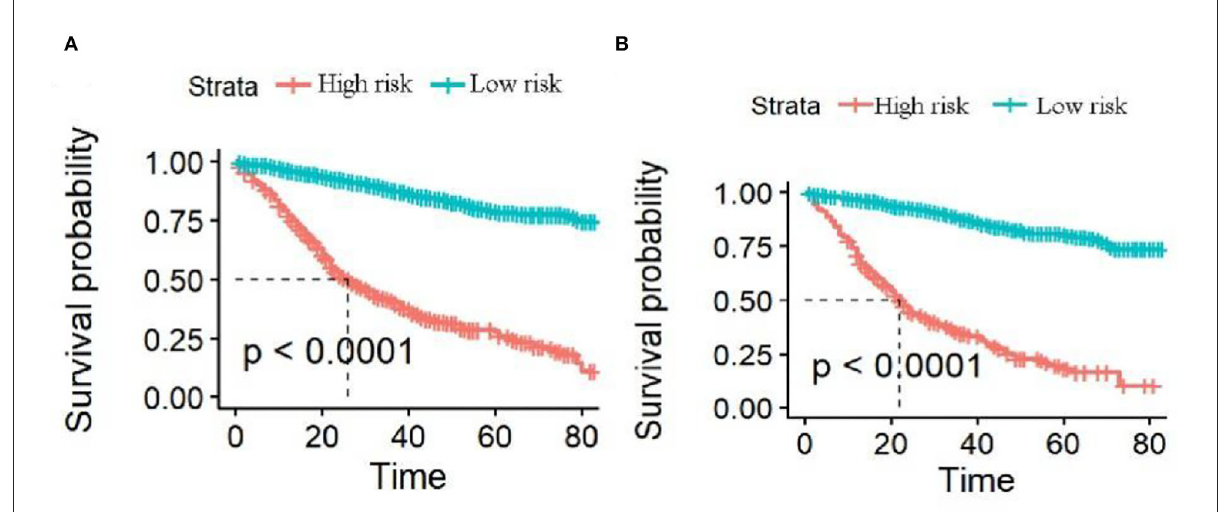
FIGURE7 Survival curves of high-risk and low-risk groups predicting 1-, 3-, and 5-year overall survival (OS). (A,B) Are the 1-, 3-, and 5-year survival curves of the modeling and validation sets, respectively.